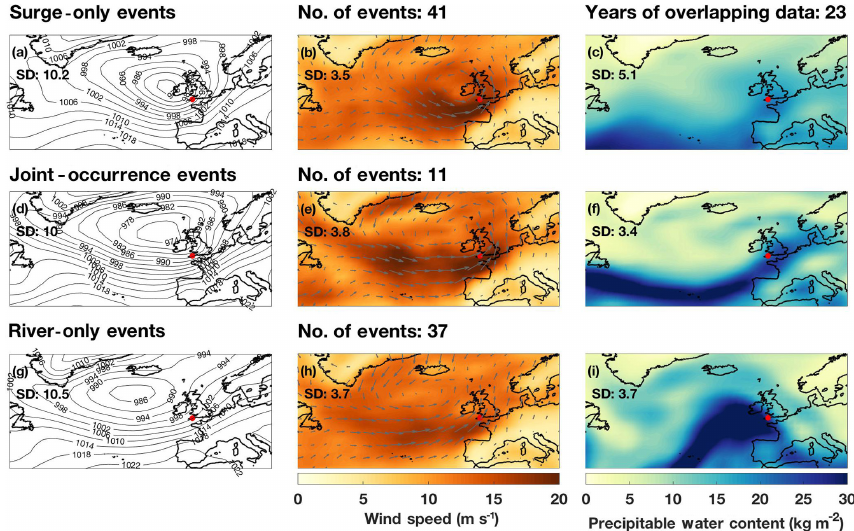
Figure 7. Meteorology conditions for Devonport [5]: (a, d, g) sea-level pressure (mbar), (b, e, h) wind speed (ms − 1 ) and direction (grey arrows), and (c, f, i) precipitable water content (kgm − 2 ) during (a, b, c) high skew surge events only, (d, e, f) both high skew surge and high river discharge events, and (g, h, i) extreme high river discharge events only. SD corresponds to the averaged standard deviation over the grid for each variable across the selected